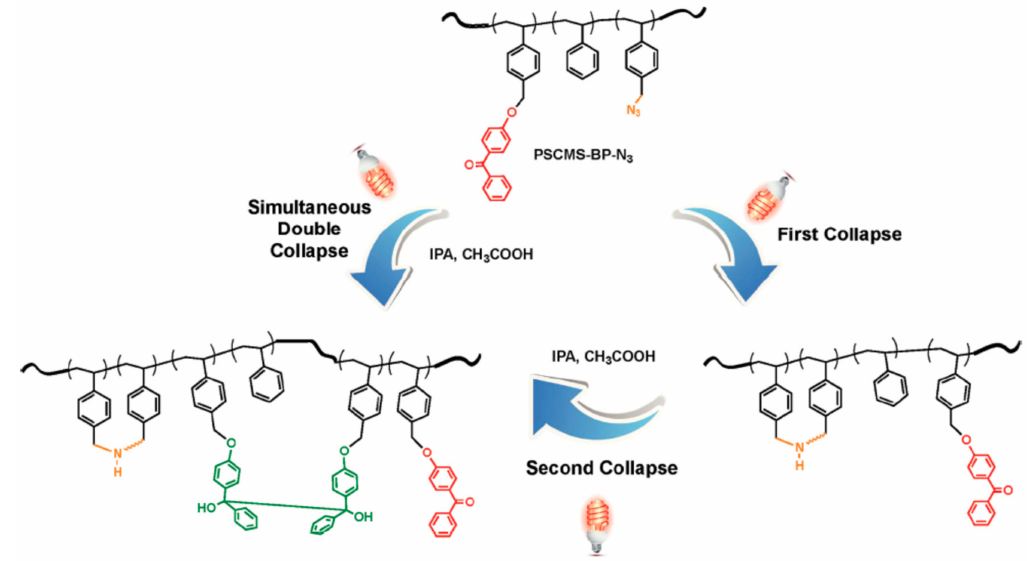
Figure 16. Illustration of SCNP formation via simultaneous ( left ) or sequential ( right ) photoactivated double folding / collapse. IPA = isopropyl alcohol. Reprinted from [55] with